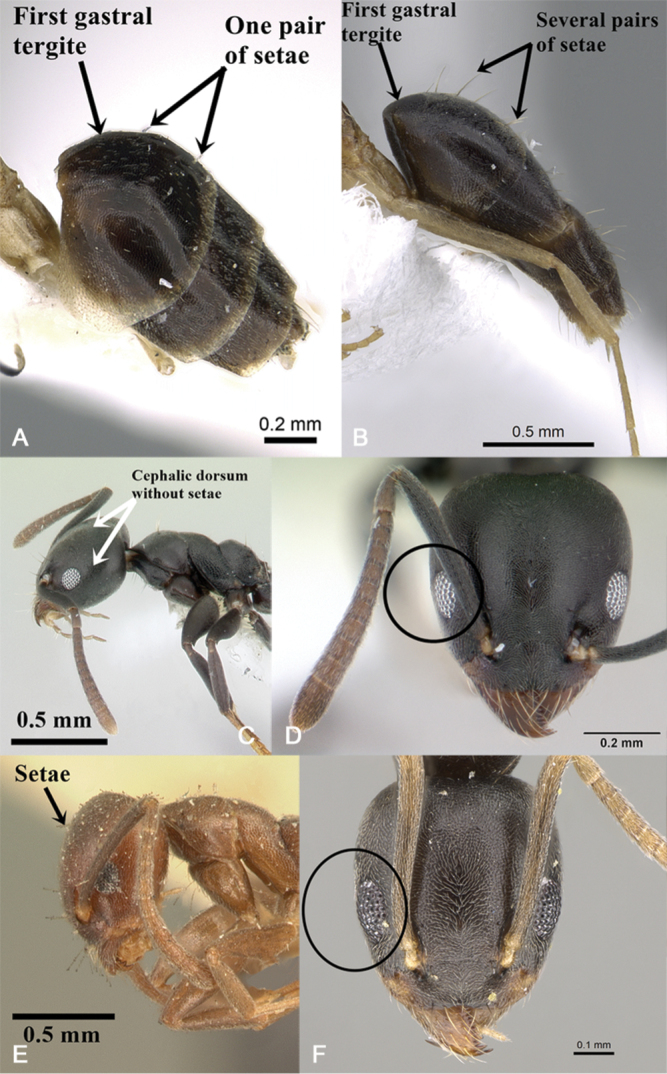
Technomyrmex key illustrations: AT.briani, gaster in profile, CASENT0906400BT.setosus, gaster in profile, CASENT0746639CT.albipes, head and mesosoma in profile, CASENT0178469DT.albipes, head in full-face view, CASENT0178469ET.difficilis, head in profile, CASENT0101932FT.difficilis, head in full-face view, CASENT0922887, images from www.AntWeb.org.